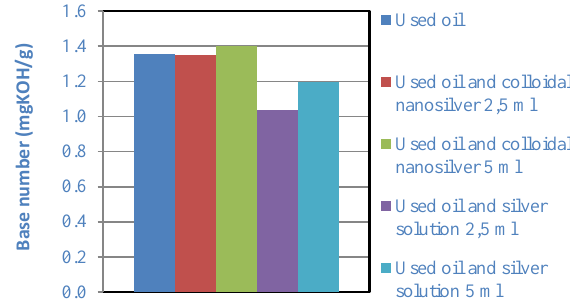
Fig. 4. Basenumber of usedoil and usedoil with colloidalnanosilver and silversolution The base number for fresh oil (Fig. 5) is 3.907